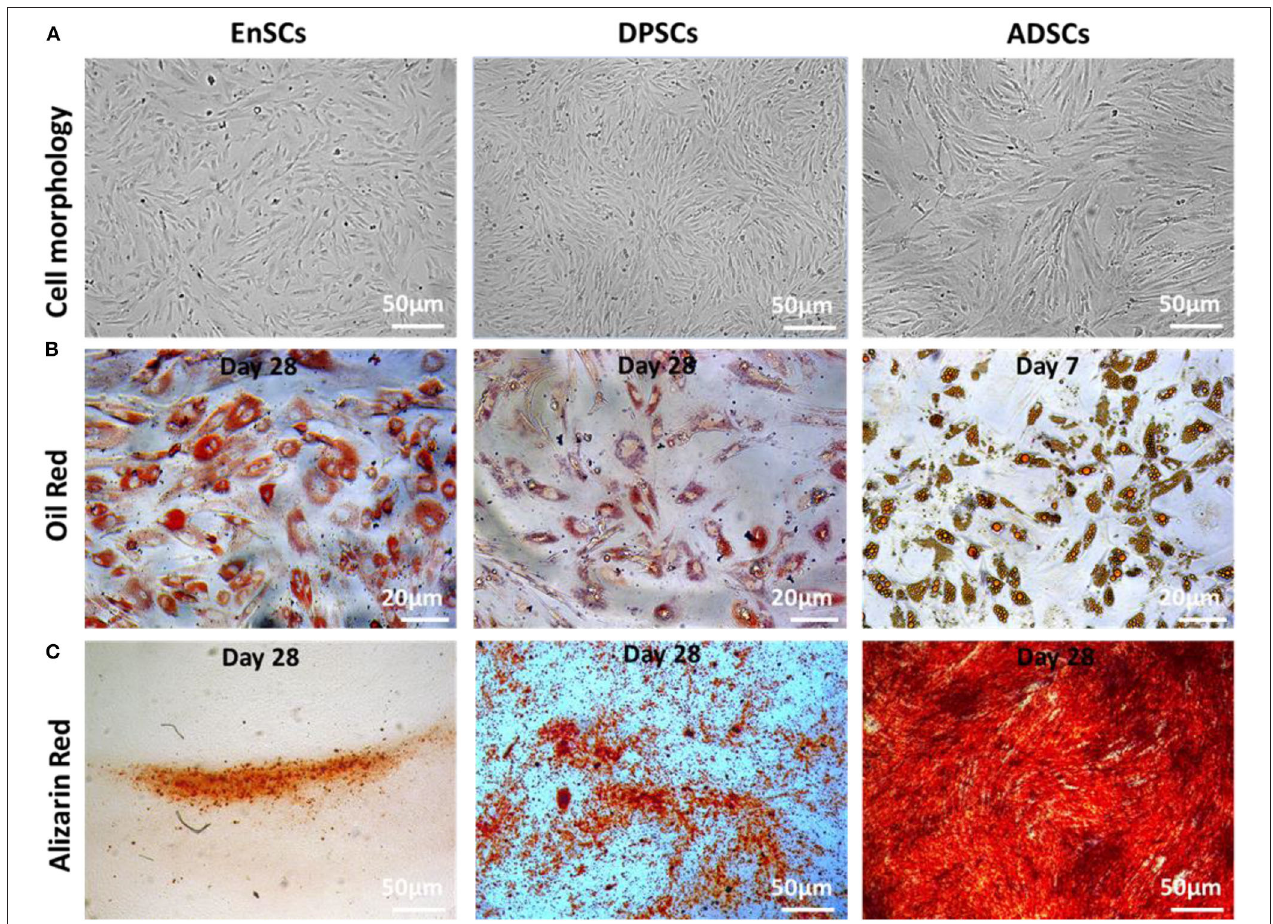
FIGURE 2 | Morphology and multilineage differentiation of MSCs derived from different tissues. All MSCs exhibited spindle-shaped morphology ( A , scale bar = 50 µ m). The differentiation of adipocytes and osteoblasts were verified by Oil Red O ( B , scale bar = 20 µ m) and Alizarin Red ( C , scale bar = 50 µ m), respectively. The representative picture is captured from one of 3 independent